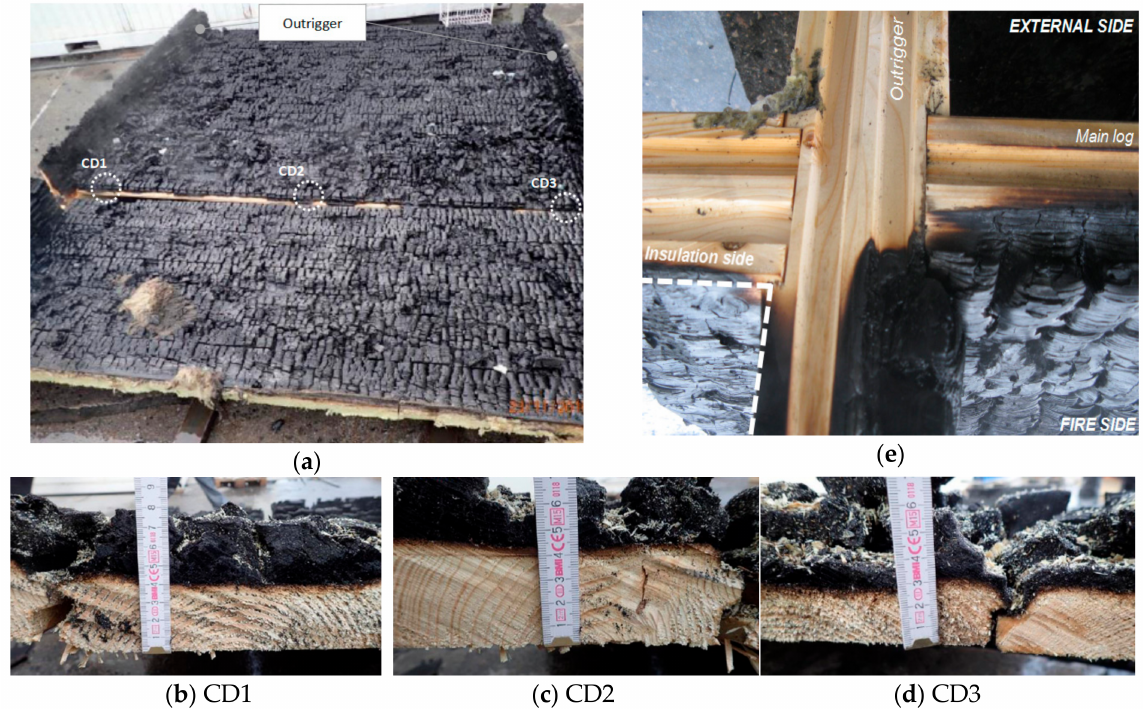
Figure 5. Photo of the W80 specimen at the end of the fire test. ( a ) Charred internal surface, with ( b – d ) cross-sectional details in the main logs and ( e ) top view detail of the left outrigger (in evidence, the different charred thickness on the insulated or unprotected surfaces).